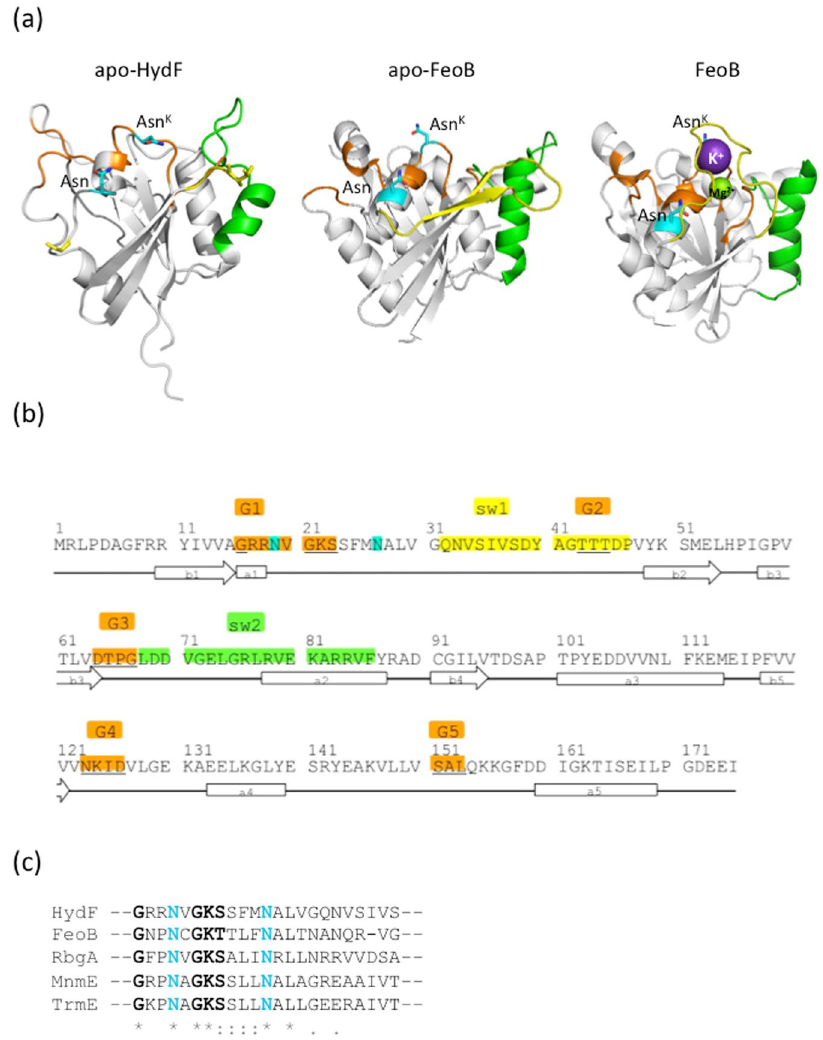
Figure 1. Structural features of the GTPase domain of HydF (Panel a, left. PDB ID: 3QQ5) and of the G-domain of Streptococcus thermophilus FeoB in the apo form (Panel a, middle. PDB ID: 3LX5) and in the holo- form binding GDP_AlF4 (Panel a, right. PDB ID: 3LX8). The magnesium atom that binds at the active site is shown as a green sphere, and the potassium atom as a violet sphere. The GDP_AlF4 ligand is not shown. GTP binding residues (orange), sw1 (yellow) sw2 (green), conserved Asn (cyan) are highlighted. The colour code is adopted from ref. 37 and maintained in the displayed structure. Note that in the structure of the GTPase domain of HydF sw1 is almost completely unresolved and consequently not displayed. Panel b: aminoacid sequence of HydF GTPase domain, with positions of G1–G4 (orange), sw1 (yellow) and sw2 (green) indicated. G5 (orange) corresponds to the less conserved G domain motif, that usually participates in recognition of the guanine base. Asparagine residues highly conserved in K + activated small GTPases are marked in cyan. Secondary structure elements are also indicated. Panel c: Detail of the multiple sequence alignment (MSA) of HydF, FeoB, RbgA, MnmE and TrmE GTPase domains, generated by Clustal Omega algoritm. An * indicates positions which have a single, fully conserved residue, a: indicates conservation between groups of strongly similar properties and a. indicates conservation between groups of weakly similar properties. The complete MSA is reported in Supplementary Fig. S1. G1 motif and conserved asparagine residues are highlighted with black and cyan bold characters,